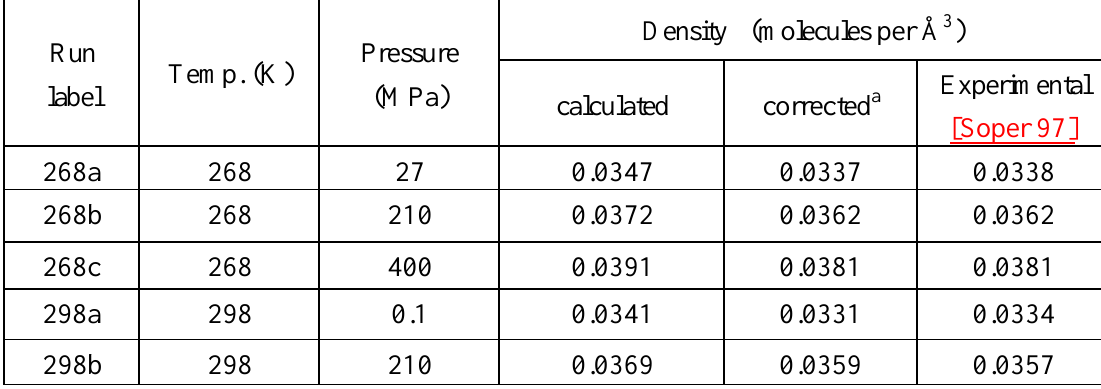
Table 2. Number density of liquid water at different parameters of state.